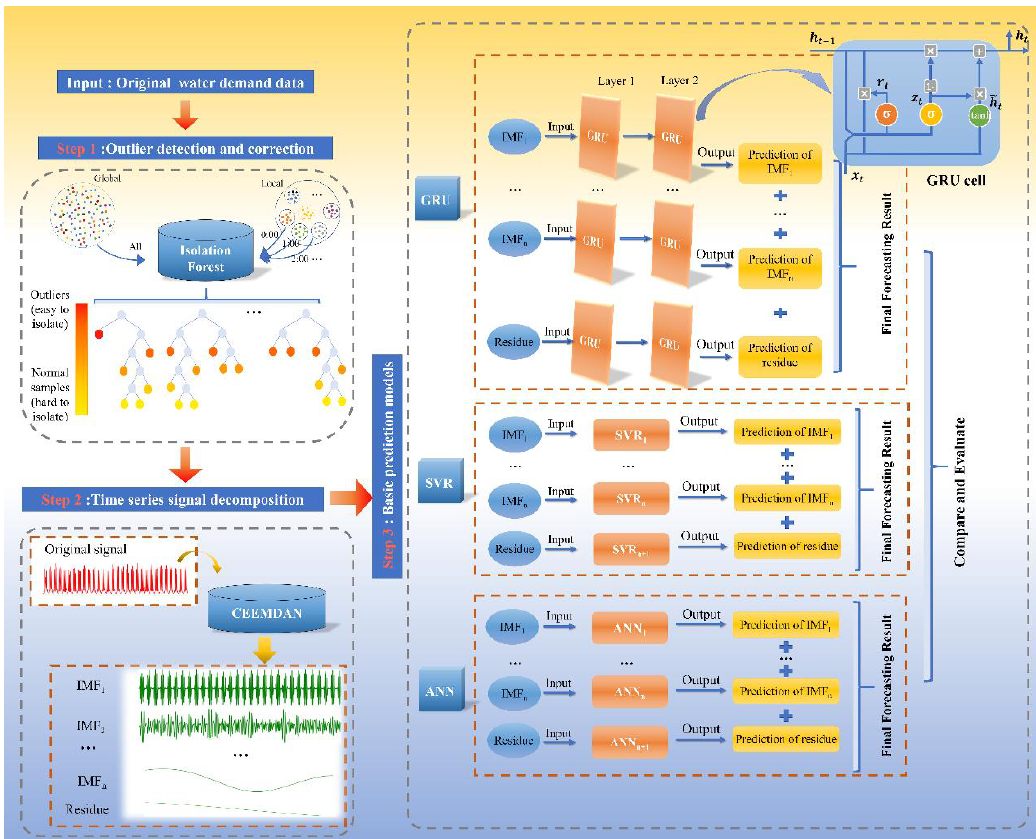
Figure 1. The flowchart of the proposed method including outlier detection and correction, time series signal decomposition, and basic forecasting models.